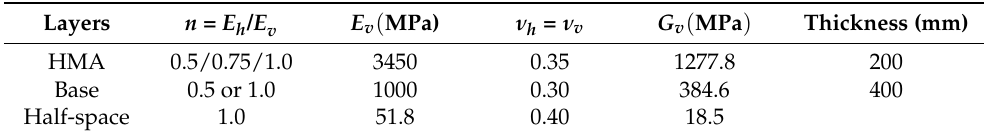
Table 5. Cases used for the analysis of the influence of the horizontal Young’s modulus of trans- verse